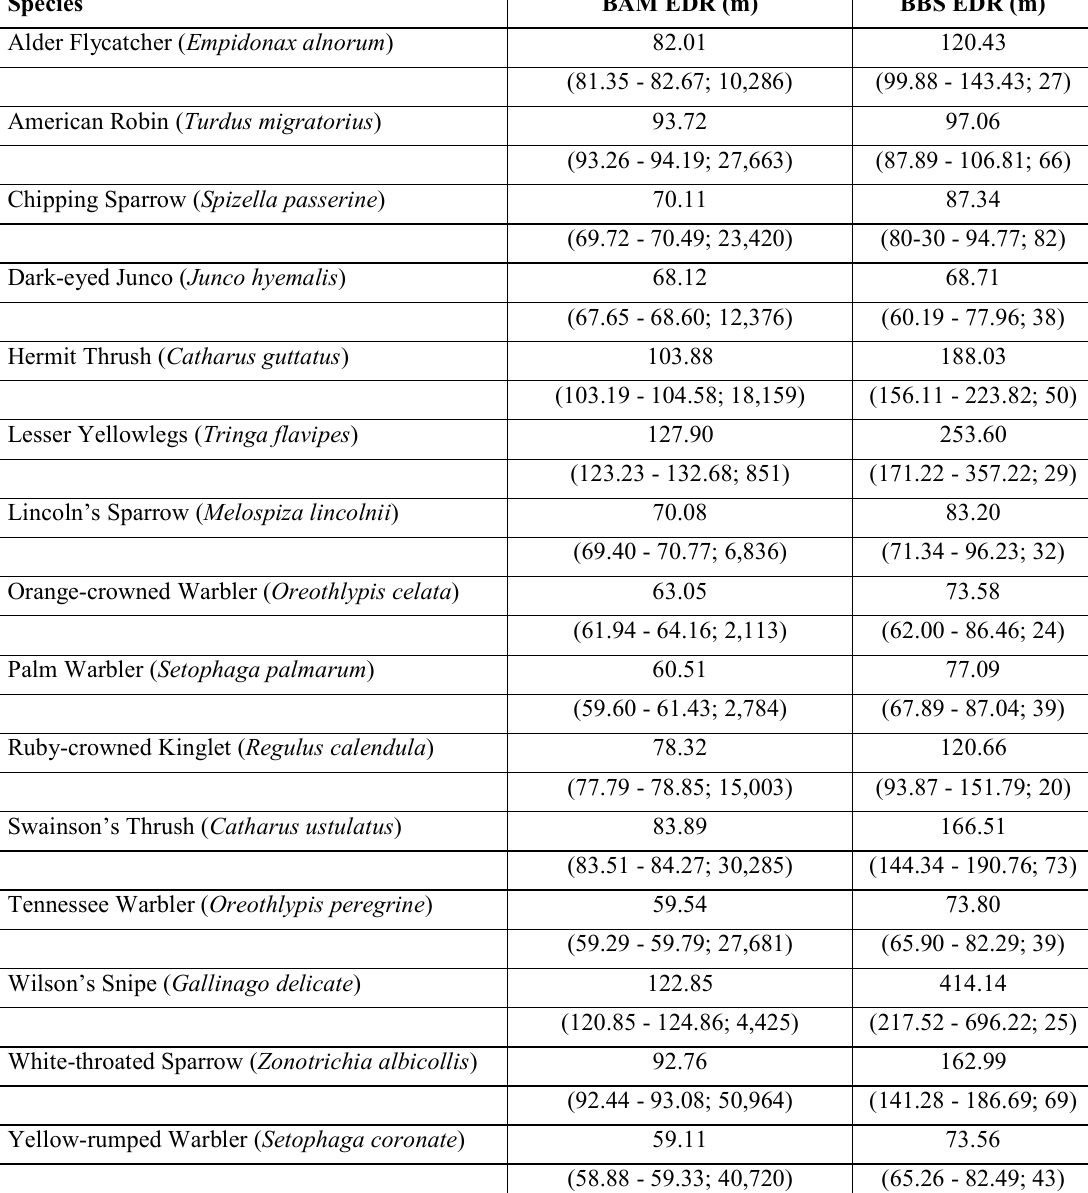
Table A1.1. EDR estimates for the 15 species with 20 detections from BBS surveys on 3 routes in the Northwest Territories. Estimates generated from the BAM database are presented for comparison. In parentheses are upper and lower 90% confidence intervals followed by the sample